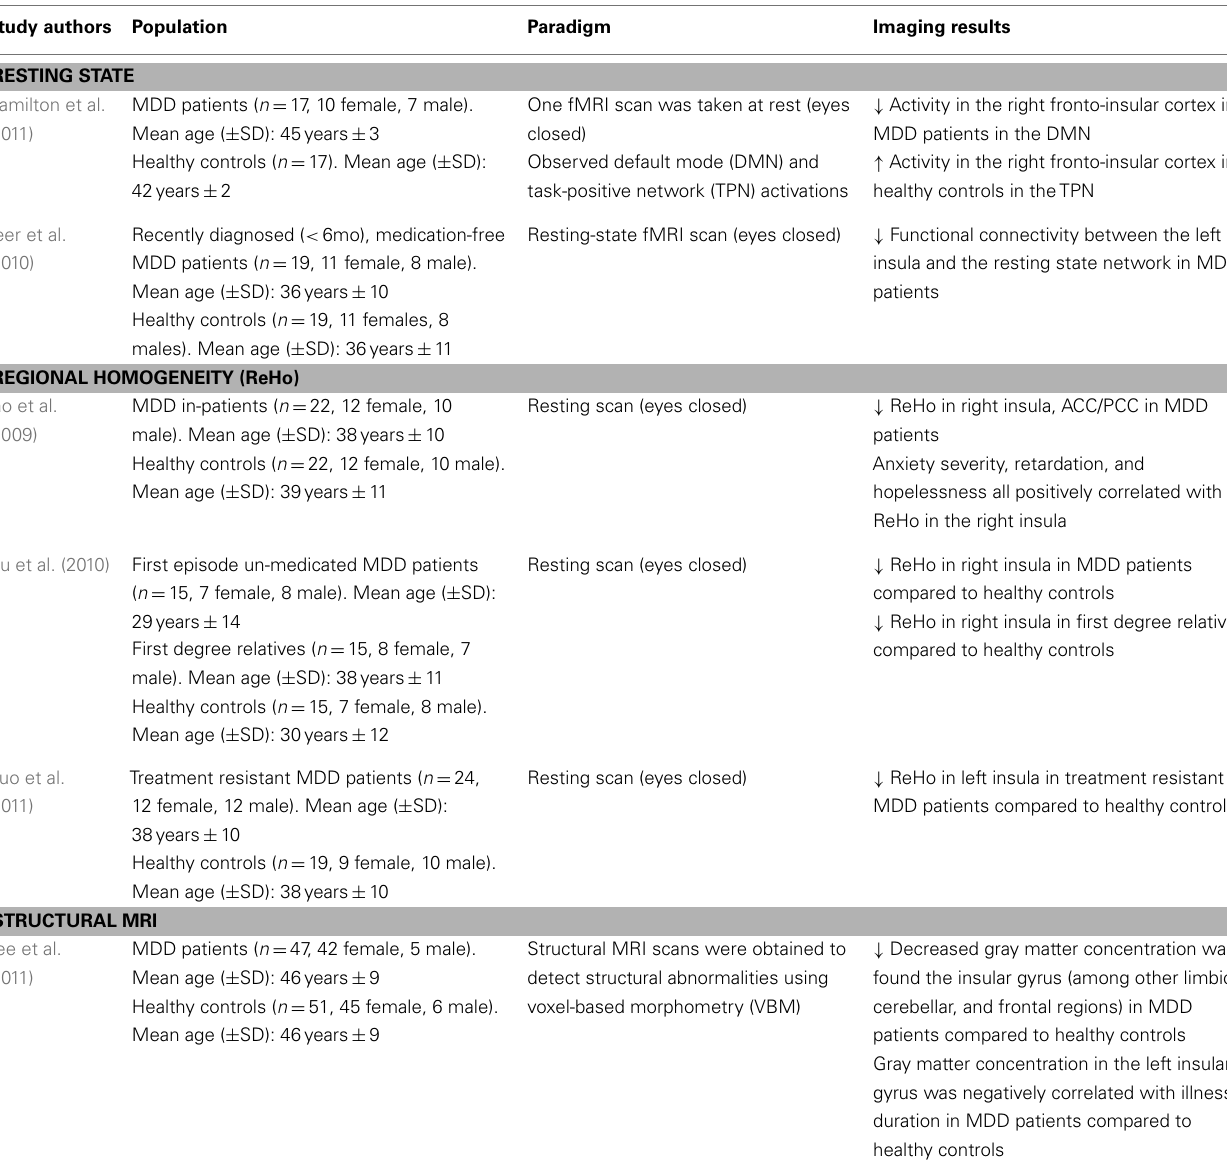
Table 1 | Imaging studies using a resting state paradigm to examine functional and structural abnormalities in major depressive disorder